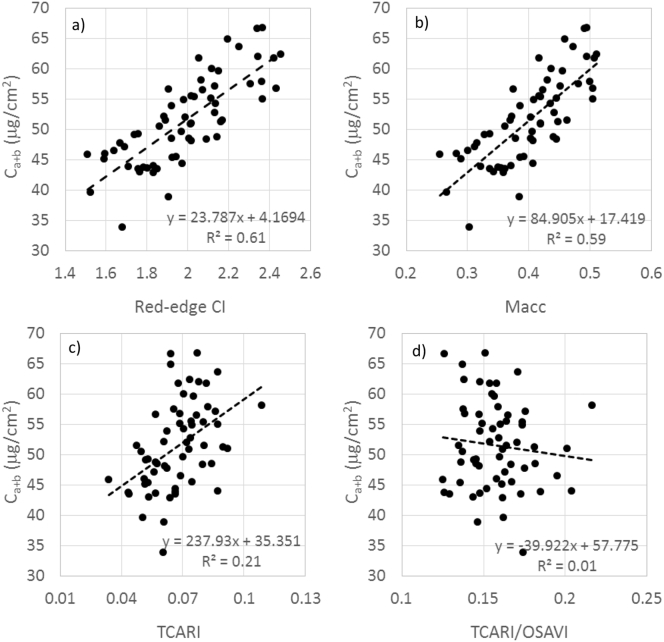
Relationships obtained between the red-edge indices CI (a), Macc (b), TCARI (c) and TCARI/OSAVI (d) calculated from the hyperspectral reflectance of pure tree crowns and the field-measured needle Ca+b content.